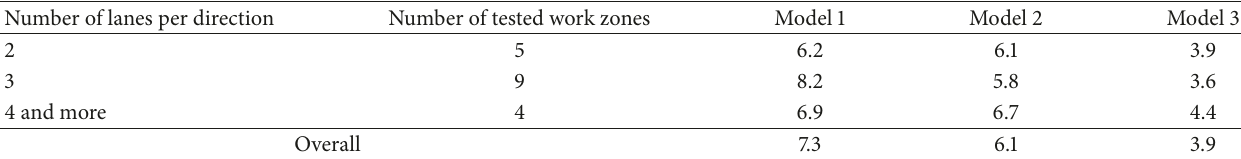
Table 1: RMSE of the three models (km/h).